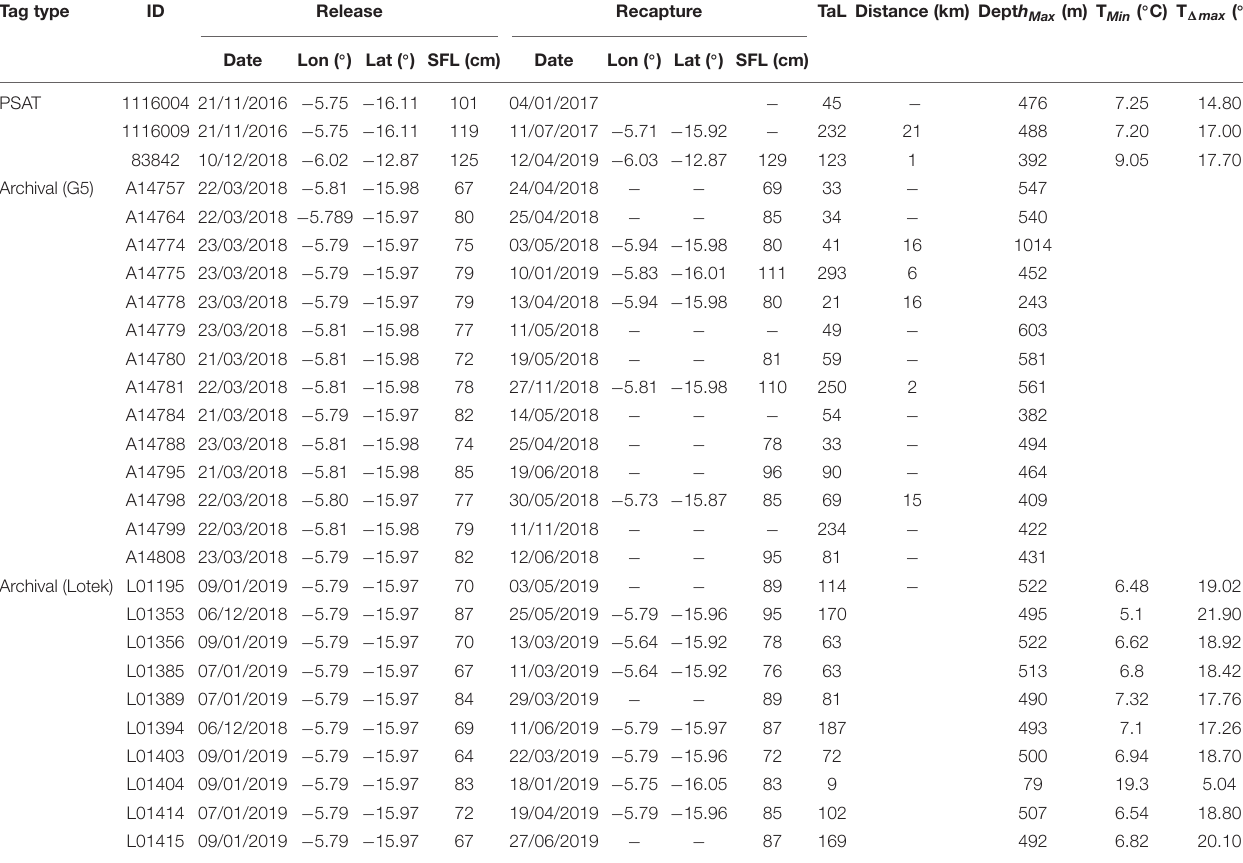
TABLE 1 | PSAT and archival tag release and recovery information for yellowfin tuna ( Thunnus albacares ) tagged in the St Helena EEZ, including the date, longitude (lon) and latitude (lat) of release and recovery. Tag